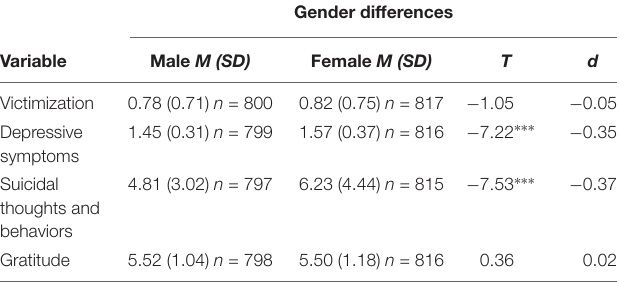
TABLE 3 | Gender differences in the studied